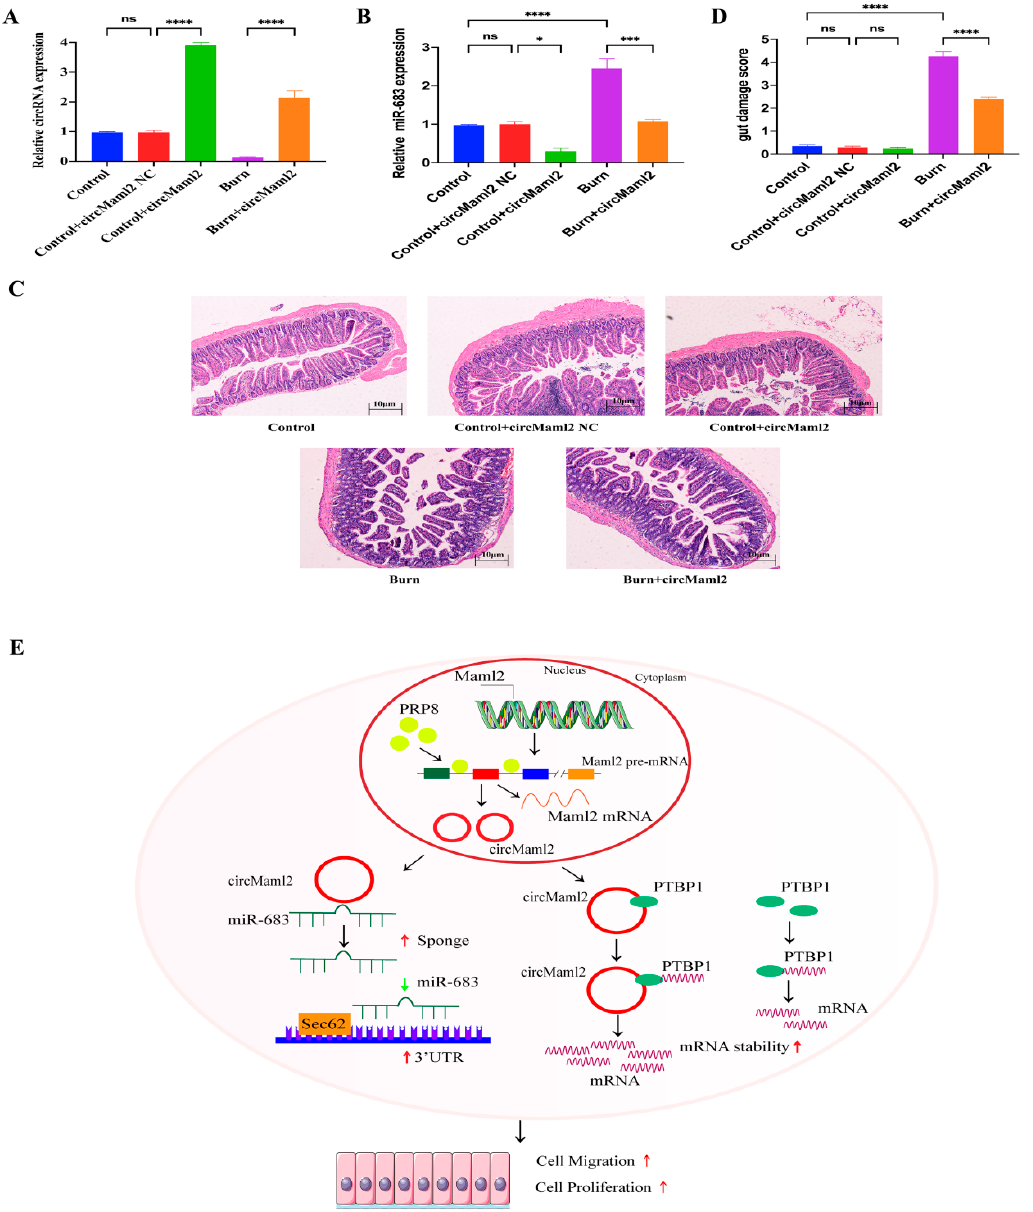
Figure 8. CircMaml2 Can Promote the Repair of Intestinal Mucosal Injury in Burned Mice. ( A ) Expression of circMaml2 was detected by qRT-PCR in the control group, burn group, and burn + circMaml2 group, respectively (**** p < 0.0001, ordinary one-way ANOVA). ( B ) The expression of miR-683 was detected by qRT-PCR in the three groups (* p = 0.0164, *** p = 0.0001, **** p < 0.0001, ordinary one-way ANOVA). ( C , D ) H&E staining and intestinal epithelium damage scoring system revealed the damage of the intestinal mucosa (**** p < 0.0001, ordinary one-way ANOVA, n = 10). ( E ) Schematic diagram of the mechanism of circMaml2 prompted by PRP8, interacting with protein PTBP1 and miR-683 to regulate cell proliferation and migration through Ebf1 and Sec62. All data are presented as mean + SEM. ns, not significant. n = 3.